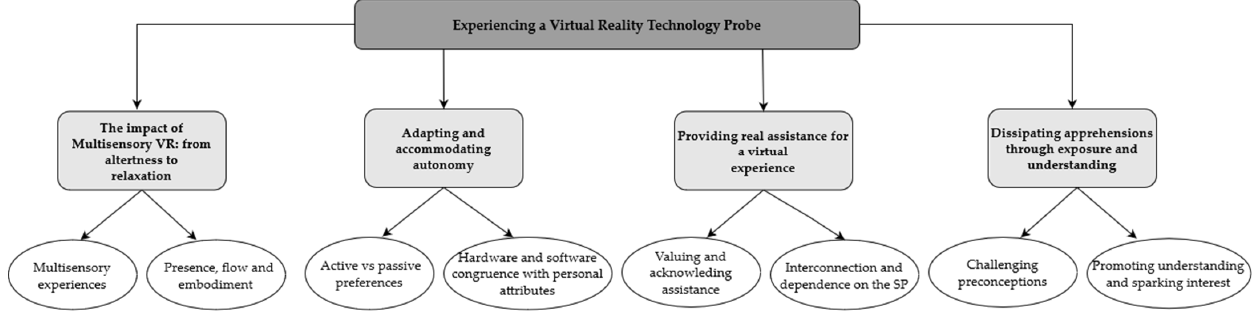
Figure 5. Thematic map of findings illustrating the overarching themes corresponding subthemes.